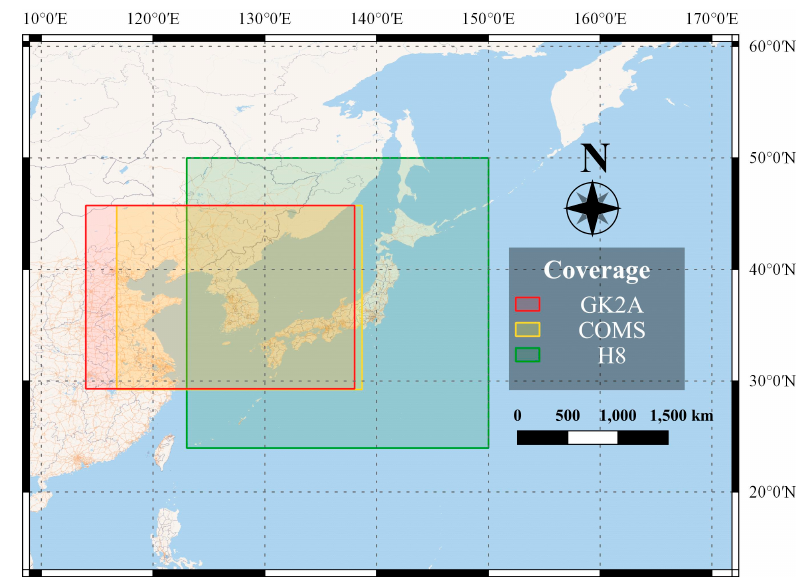
Figure 4. Geographic coverage of COMS and GK2A local area observations centered on Korea and H8 target area observations focused on Japan.